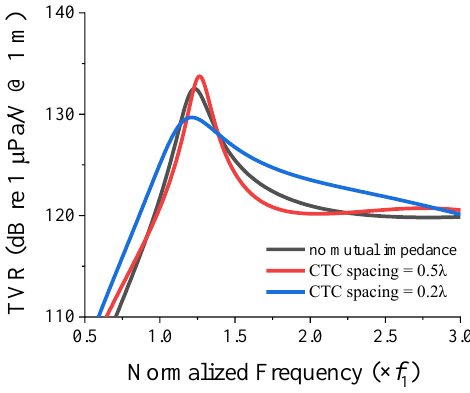
Figure 8. TVR spectra of a cymbal transducer with mutual radiation impedance added to the radi- ation load for different CTC spacings from its adjacent cymbal transducer.